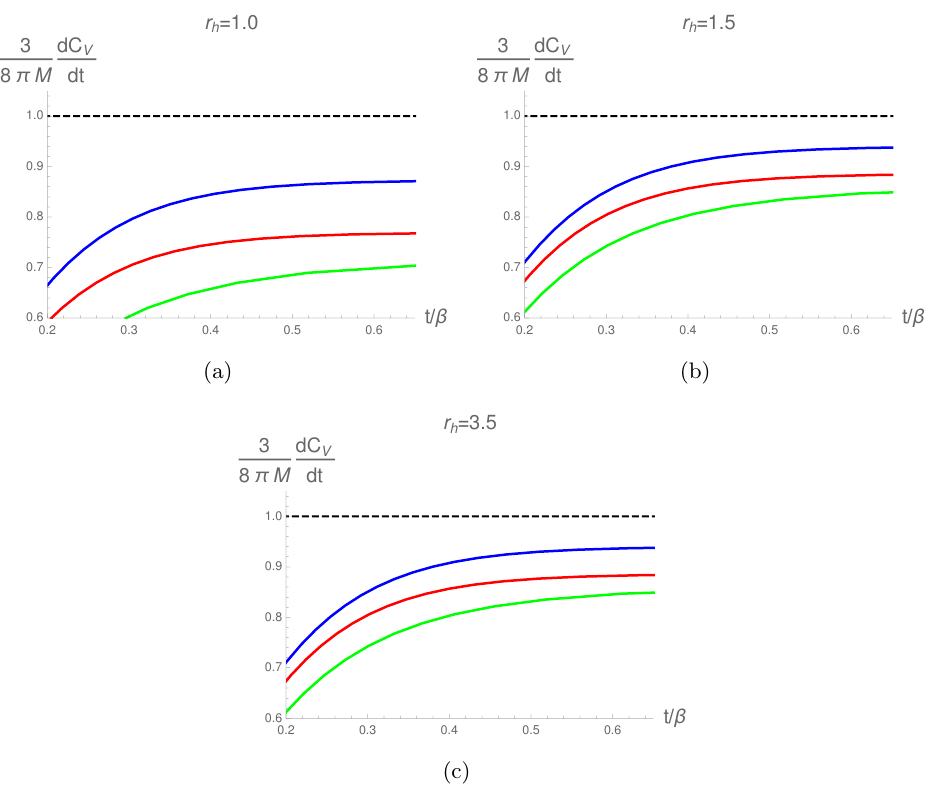
Figure 9 . dC V as a function of t=(cid:12) for di(cid:11)erent values of the horizon radius r h . Here we have used dt d = 4 and n = 2, and as before the blue curves indicate a = 0 : 05, the red curves a = 0 : 1 and the green curves a = 0 : 5.